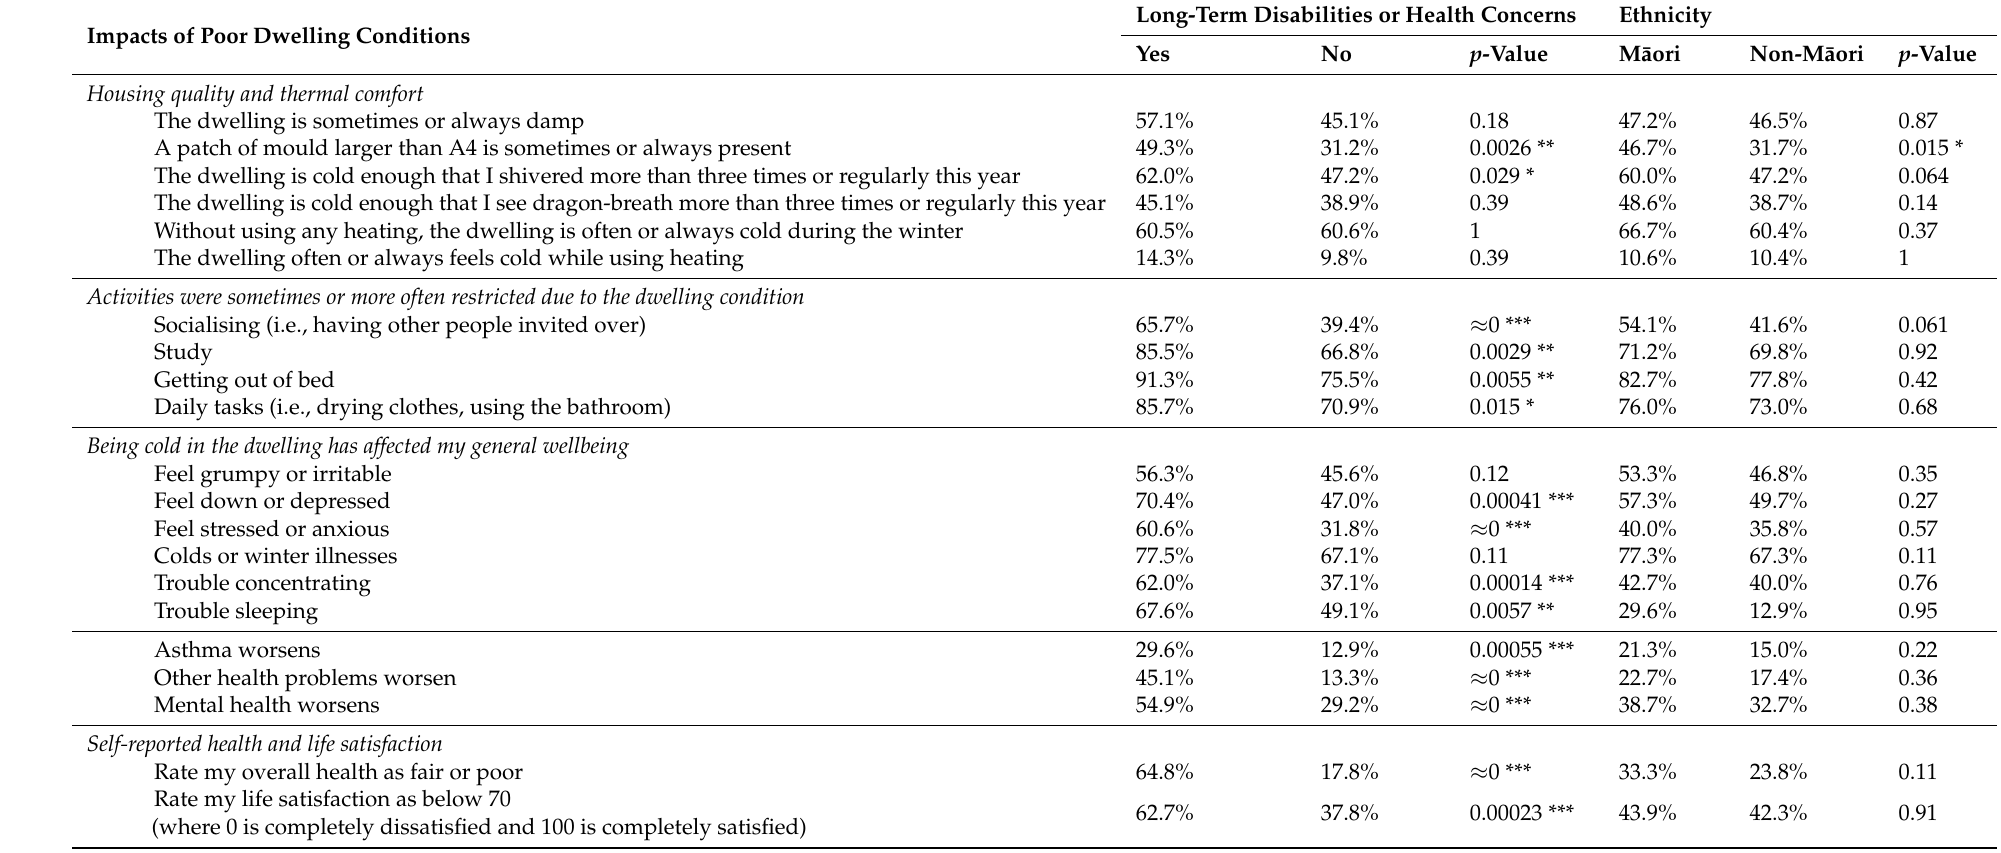
Table 2. Dwelling condition and wellbeing compared across demographic